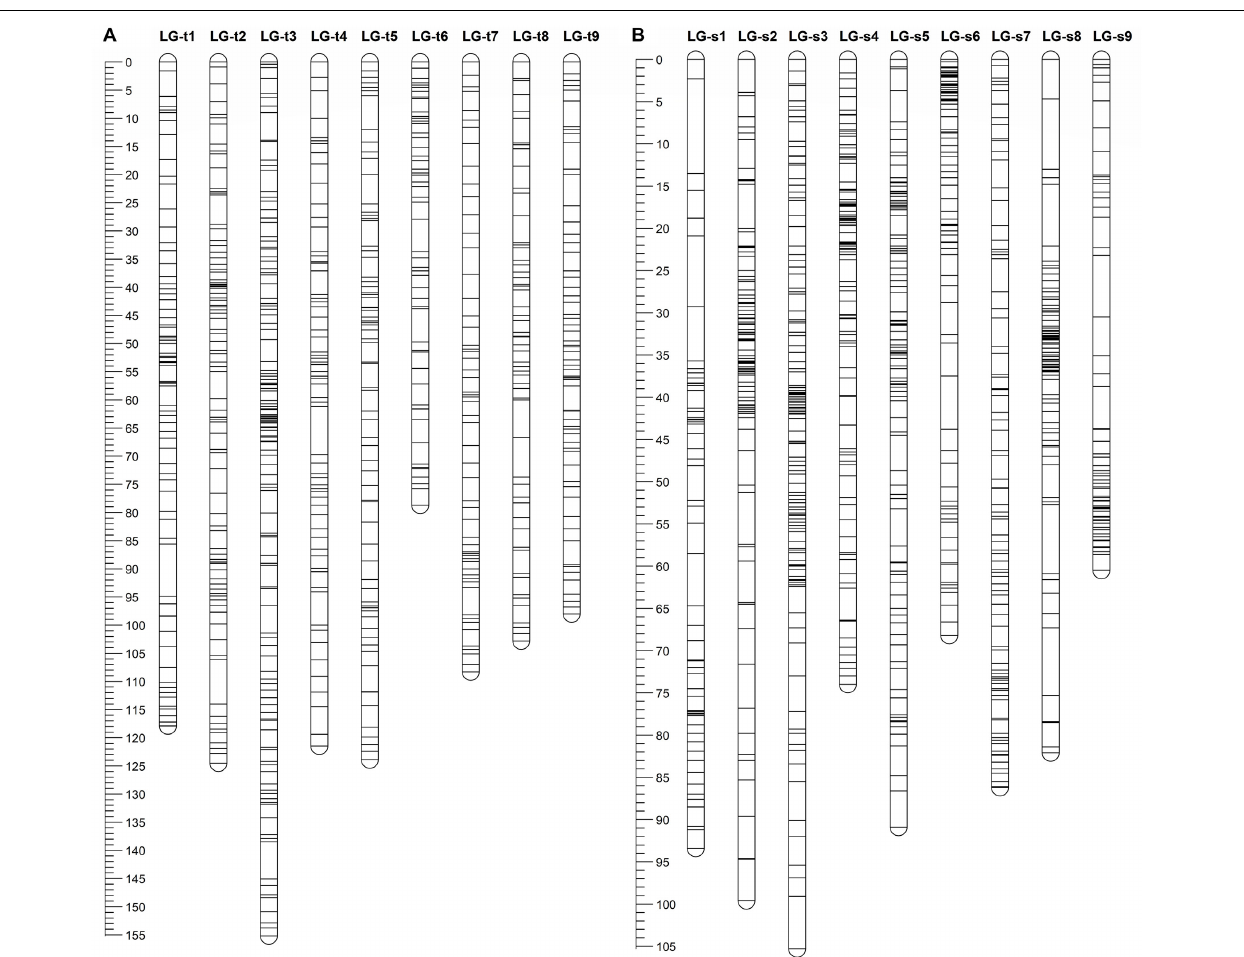
FIGURE 1 | Distribution of markers with unique loci in the genetic linkage map of trifoliate orange (A) and sweet orange (B) . The nine linkage groups correspond to the nine major scaffolds of the Clementine mandarin genome. Map distances in centiMorgans (cM) are indicated by the ruler at the left.